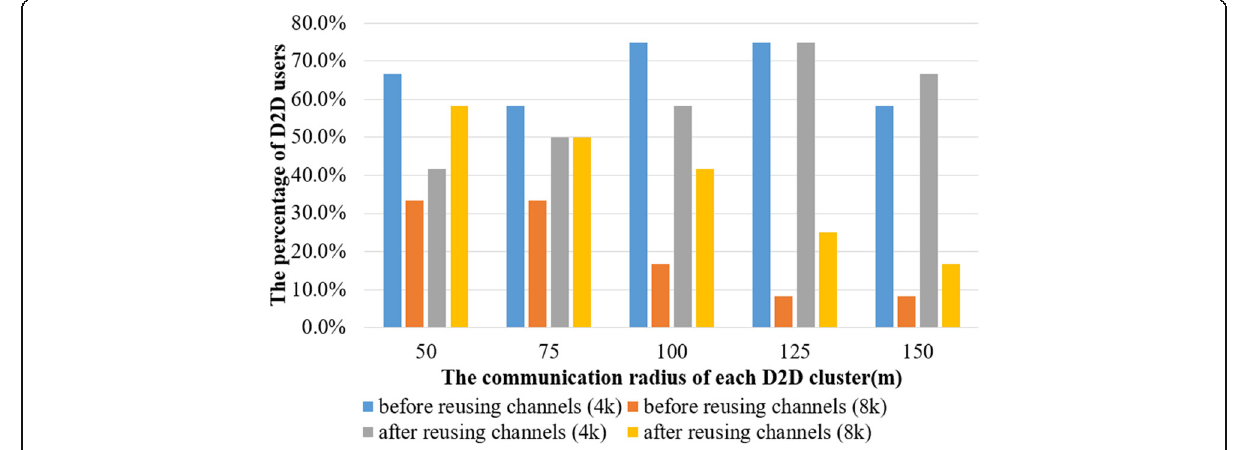
Fig. 9 The influence of D2D communication radius on the revolution of VR